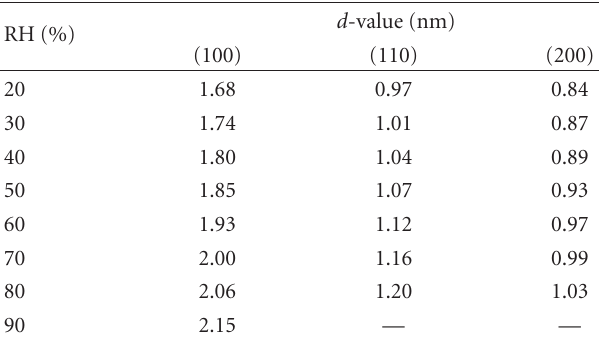
Table 1: d -Values of di ff raction peaks in the XRD patterns of the PSQ obtained from AEAPTMOS under various RH